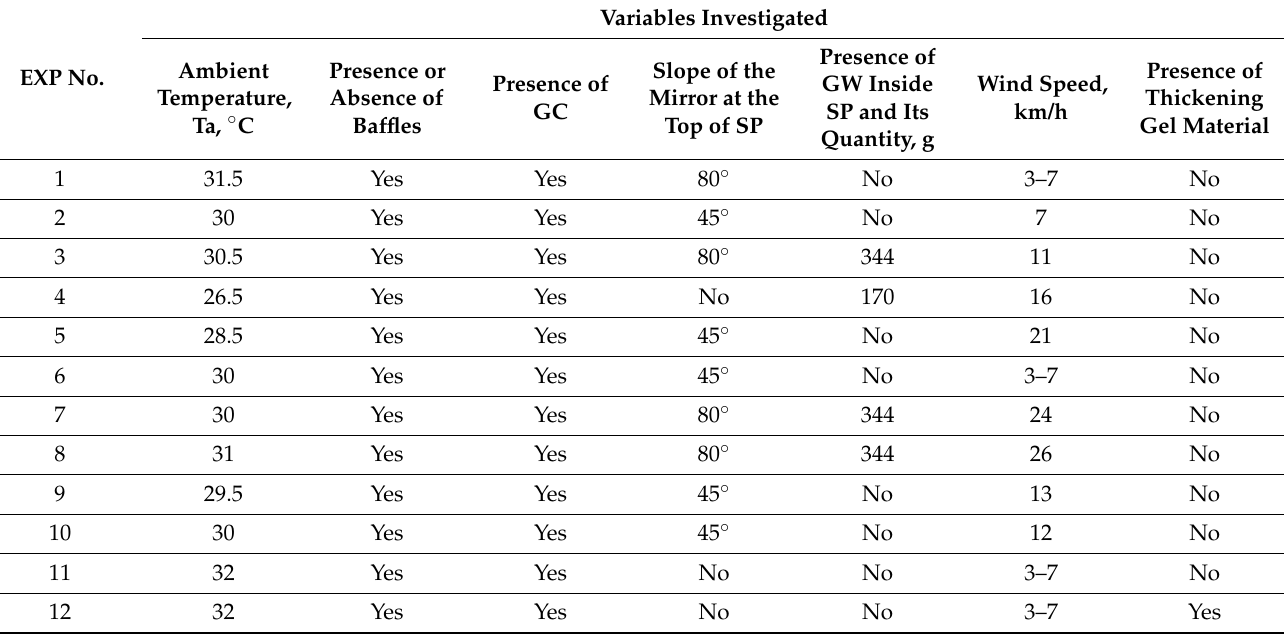
Table 1. Conditions and variables investigated throughout the